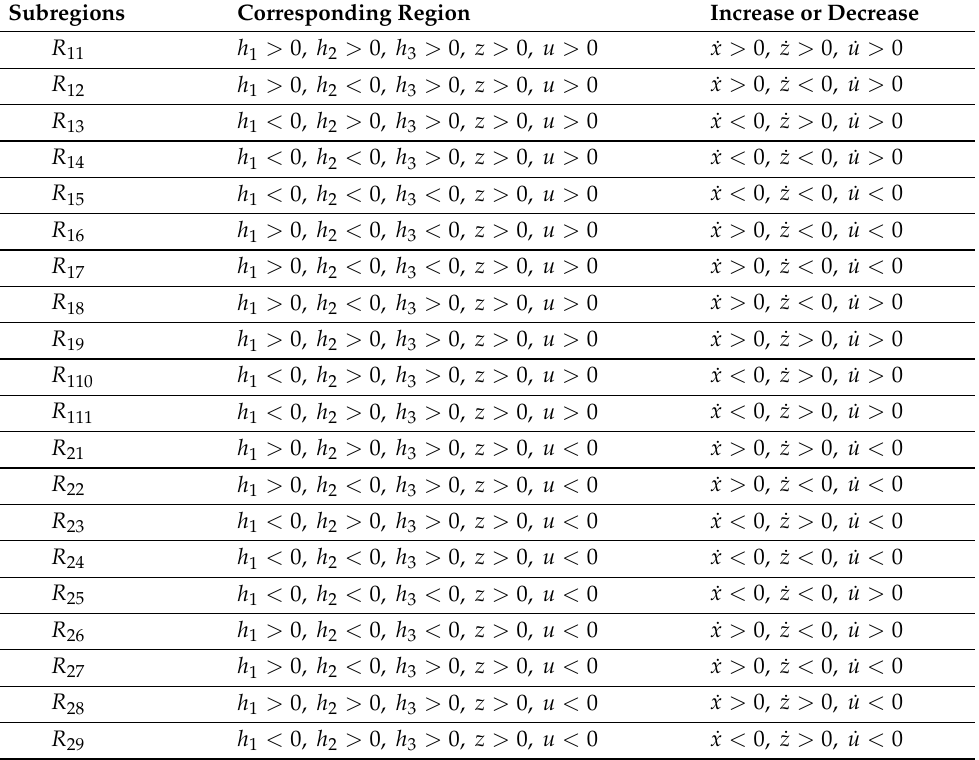
Table 6. Dynamical behavior in the twenty subregions.